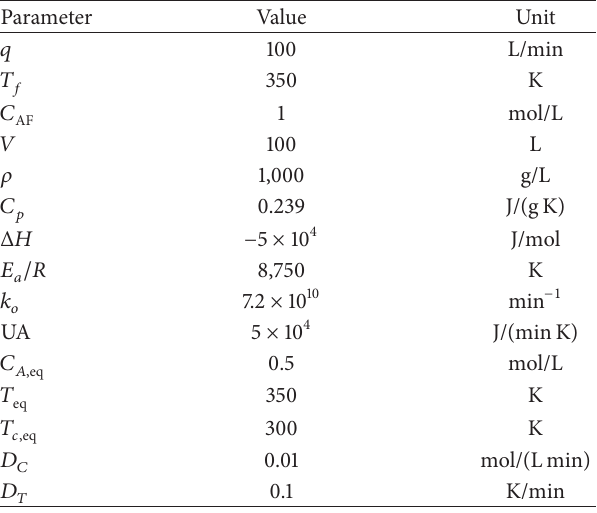
Table 1: The operating parameters of nonlinear CSTR in Example 1.